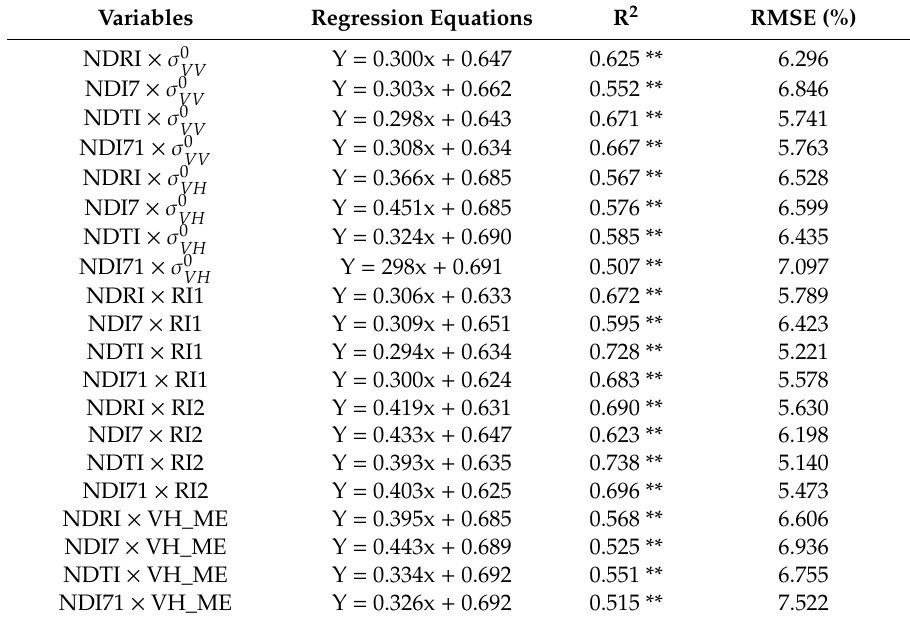
Table 4. The regression relationships between CRC and